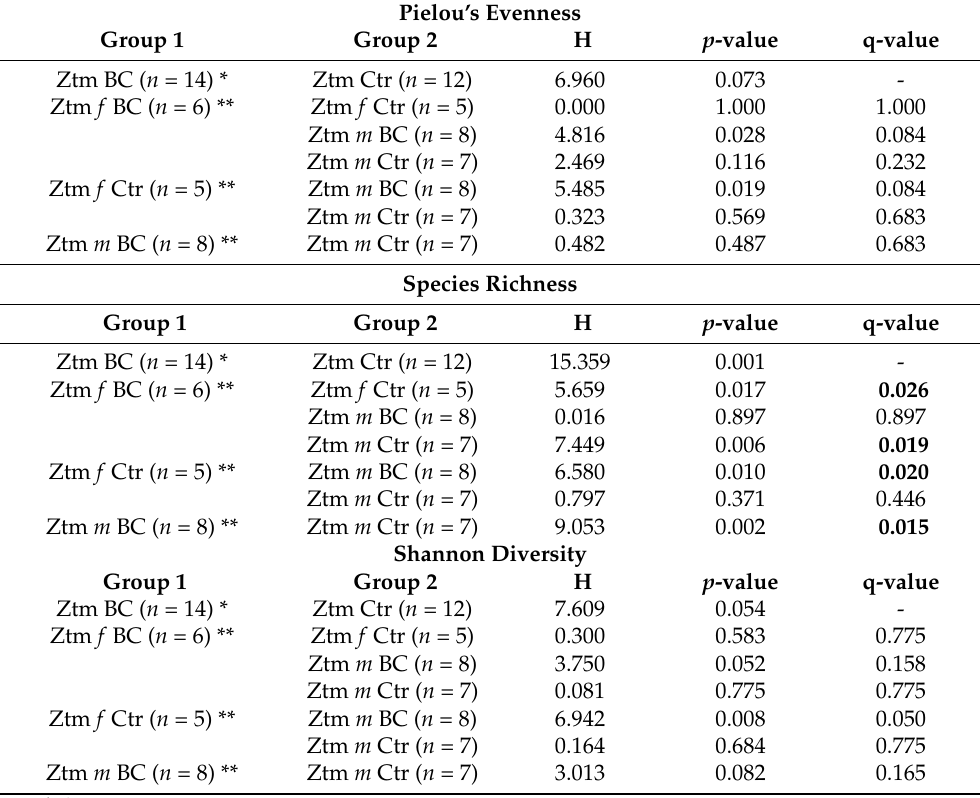
Table 2. Alpha diversity of the intestinal microbiota in Ztm mice post BC treatment. Quantified using Pielou ´ s evenness, species richness, and Shannon diversity indexes, which relate OTU rich- ness and evenness, the total number of observed species, and variation and complexity within the group. Alpha diversity analysis were performed with Kruskal–Wallis rank-sum and pairwise tests. Ztm = zonulin transgenic mice; BC = bovine colostrum treatment; Ctr = control mice; f = female; m = male; n = number of mice in each group. Pielou’s Evenness Group 1 Group 2 H p -value q-value Ztm BC ( n = 14)